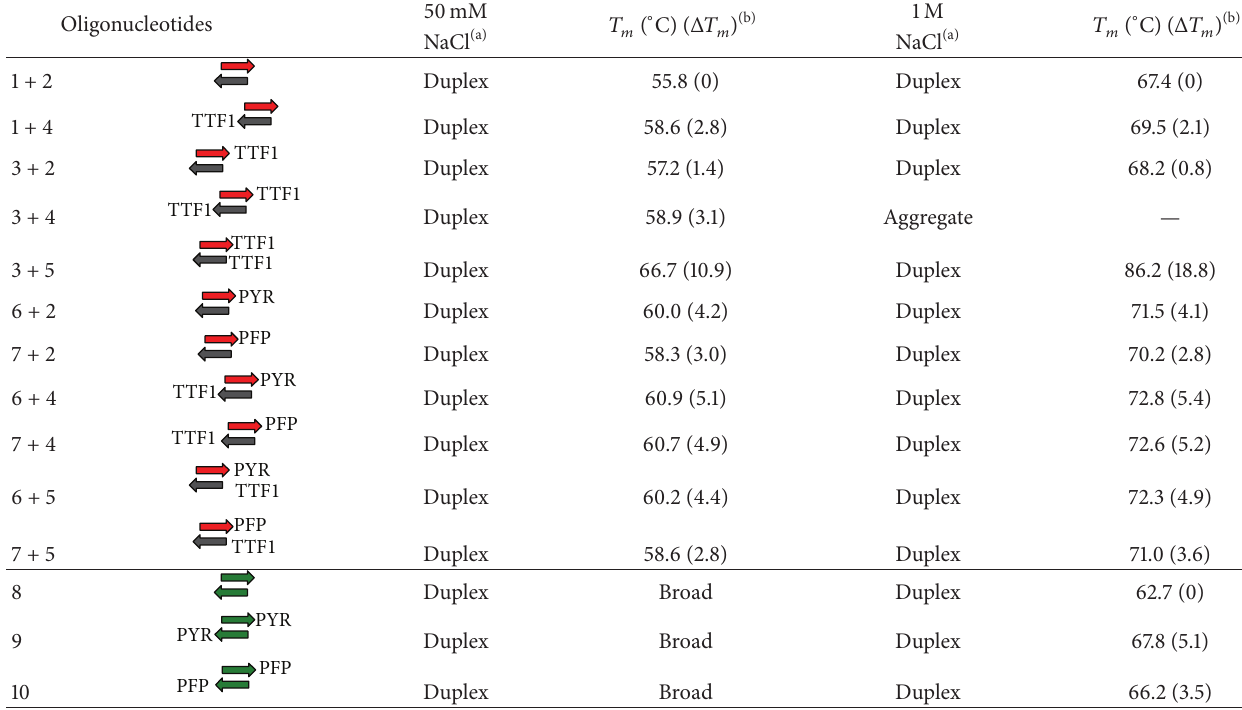
Table 2: Melting temperatures of duplexes carrying pyrenyl (PYR), 2,3,4,5,6-pentafluorophenyl (PFP), or tetrathiafulvalene (TTF1) units.